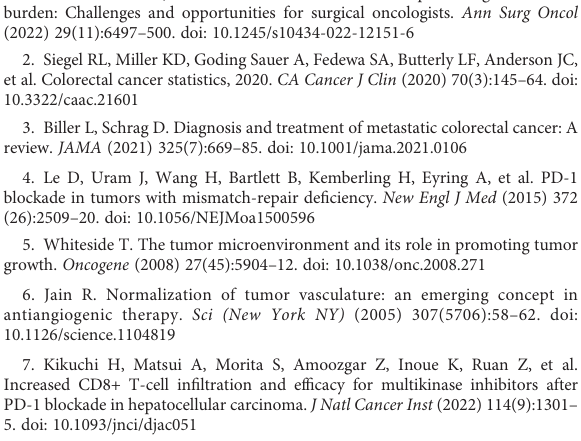
SUPPLEMENTARY FIGURE 1 Kaplan-Meier survival analysis of different angiogenesis-related genes in COAD. The red and blue line represent patients with higher expression and lower expression of ARGs respectively. SUPPLEMENTARY FIGURE 2 1587 differentially expressed gene (DEGs) between two ARGclusters were showed in Venn diagram. SUPPLEMENTARY FIGURE 3 Prognostic value of ARGs in training set. (A, B) Multivariate Cox regression via LASSO is presented, and eight candidate ARGs were selected in training cohort. SUPPLEMENTARY FIGURE 4 The expression level of 8 angiogenesis-related genes. (A – F) Compared with normal colon epithelial cells, SEMA4C, and ASNS expression were signi fi cantly increased in three CRC cell lines. PIM1, JAGN1 and RPS24 expression were signi fi cantly increased in Caco-2 and HT29 cells, but not in HCT-116 cells. TRIB2 expression was signi fi cantly increased in HT-29 and HCT-116 cells, but not in Caco- 2 cells. SUPPLEMENTARY FIGURE 5 Strati fi cation analysis of the ARG_score in COAD. (A – D) In terms of survival status and tumor stage, the proportion of deaths and stage III- IV tumors was signi fi cantly higher in the high-risk group than that in the low-risk group; in terms of age and gender, there were no signi fi cant differences between the two risk groups. (E – G) Kaplan-Meier curves depicted the survival difference between lower and higher ARG_score in the strati fi ed analysis of COAD patients. Survival expectations were lower in the high-risk group than in the low-risk group, regardless of age, gender, or tumor stage. SUPPLEMENTARY FIGURE 6 The correlation of risk score and different sided colorectal cancer (CRC). (A) The proportion of right-sided CRC (RCRC) and left-sided CRC (LCRC) patients inthedifferentriskgroup. (B) TheriskscoreofpatientswithRCRC and LRCR, higher risk score was found in RCRC. SUPPLEMENTARY FIGURE 7 The difference of immune cells and immune functions between two risk